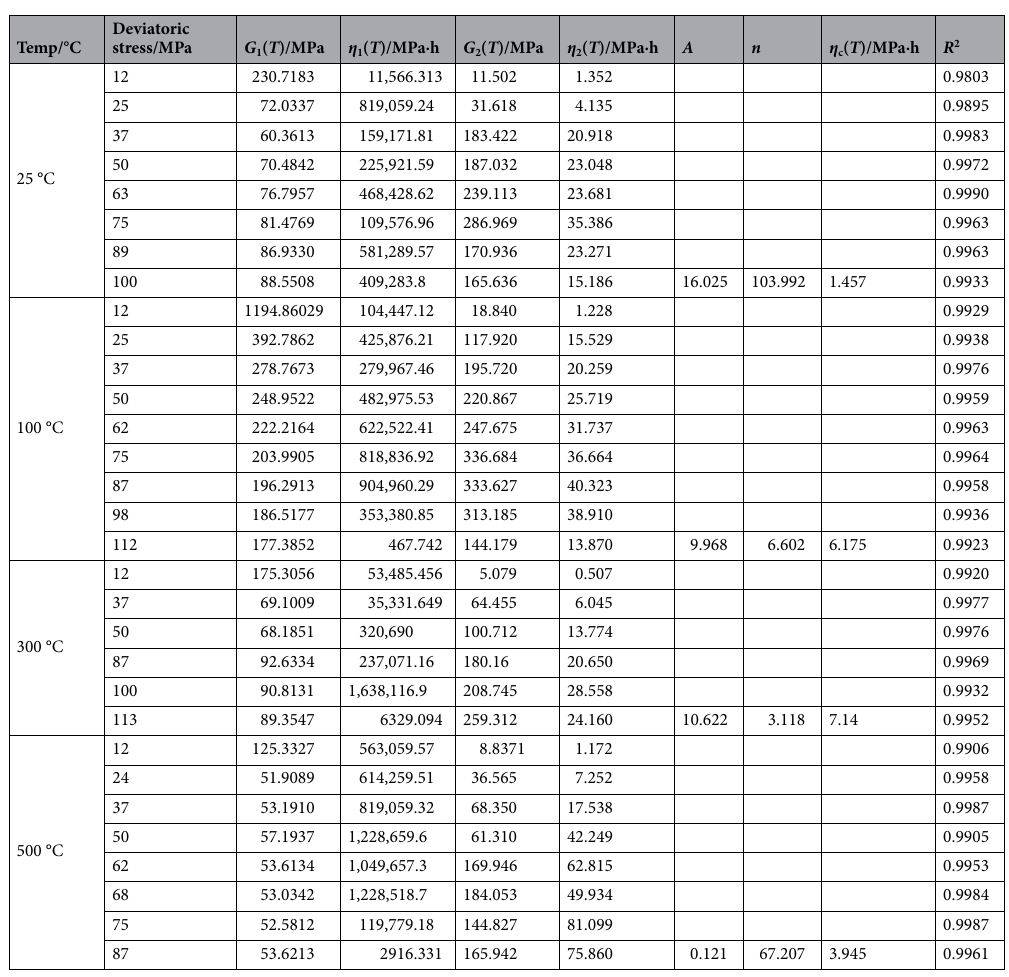
Table 1. Model parameter identification